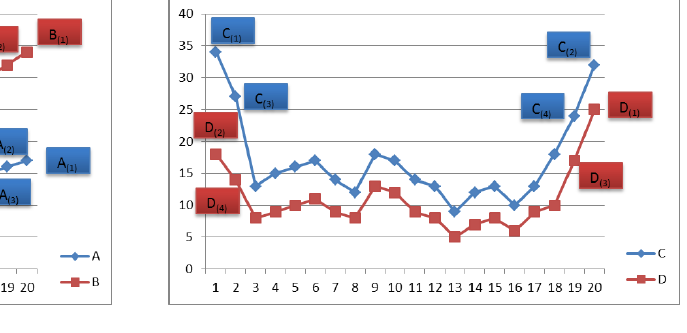
Figure 1. Time series A & B. Figure 2. Time series C & D .